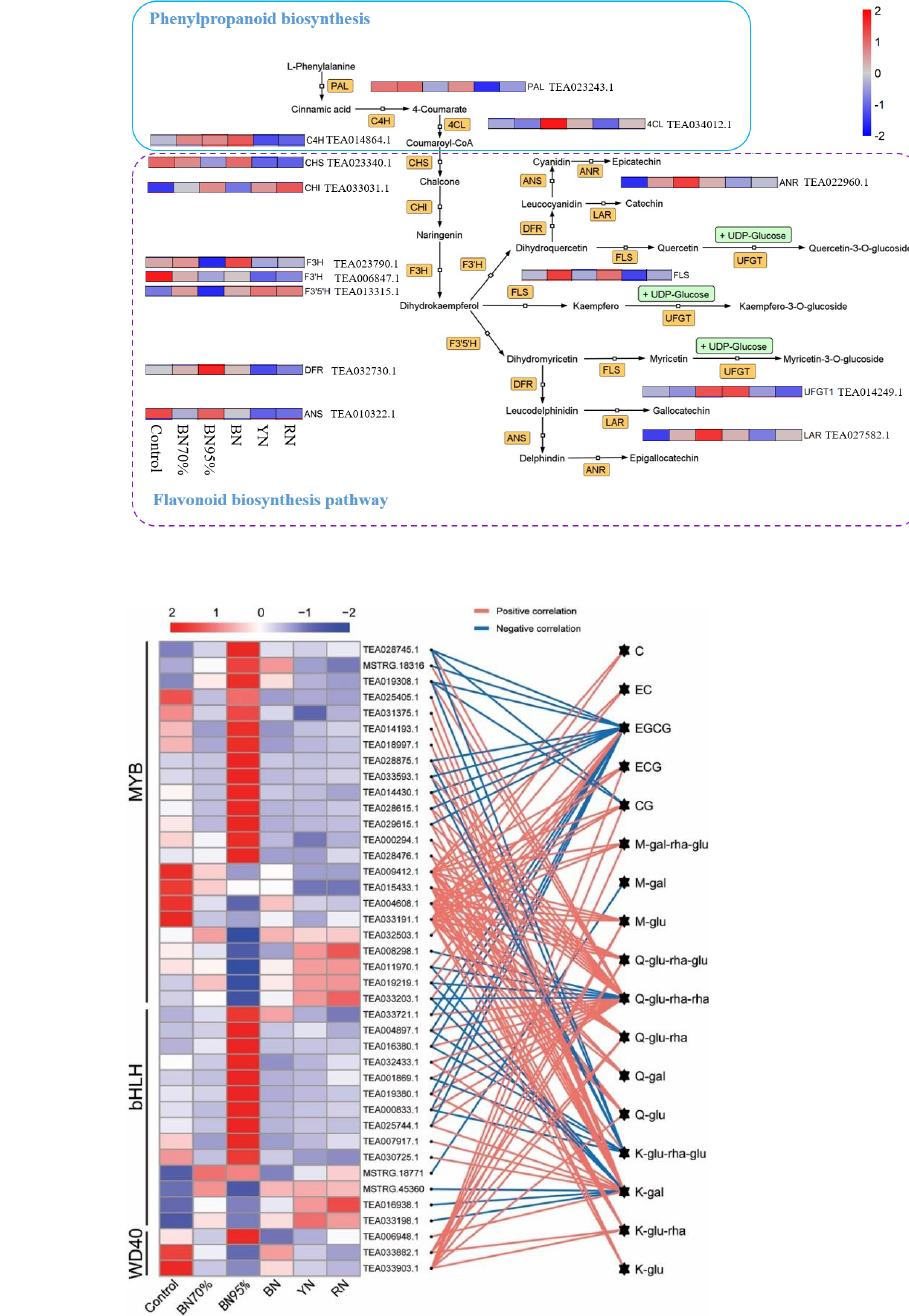
Figure 4. The impact of different shade treatments on the biosynthesis of flavonoids in tea leaves. ( A ) Visualization of the expression levels of the structural genes in the biosynthetic pathway of flavonoids; ( B ) heatmap of the expression levels of TFs and the correlations with flavonoid contents. PAL: phenylalanine ammonia lyase; C4H: cinnamate 4-hydroxylase; 4CL: 4- coumaroyl CoA ligase; CHS: chalcone synthase; CHI: chalcone isomerase; F3H: flavanone 3-hydroxylase; F3 (cid:48) 5 (cid:48) H: flavonoid 3 (cid:48) ,5 (cid:48) -hydroxylase; F3 (cid:48) H: flavonoid 3 (cid:48) -hydroxylase; FLS: flavonol synthase; LAR: leucoanthocyanidin reductase; ANR: anthocyanidin reductase; ANS: anthocyanidin synthase; DFR: dihydroflavonol 4-reductase; UFGT: UDP glucose-flavonoid- 3- O -glycosyltransferases. All the DEGs were annotated based on the PlantTFDB database (http://planttfdb.gao-lab.org/, accessed on 25 September 2021), and the MYB, bHLH, and WD40 TFs were selected for co-expression analysis, under the screening criterion of all the FPKM values of TFs being above 1 and at least one value being above 10. Pearson correlation analysis was performed based on the expression levels of these TFs and the contents of flavonoids using cor and corPvalueStudent functions in R (version 4.0.5), and the threshold screening criterion was: p < 0.05. Positive correlation: R > 0; negative correlation: R < 0. Each cell represents the mean value of n = 3